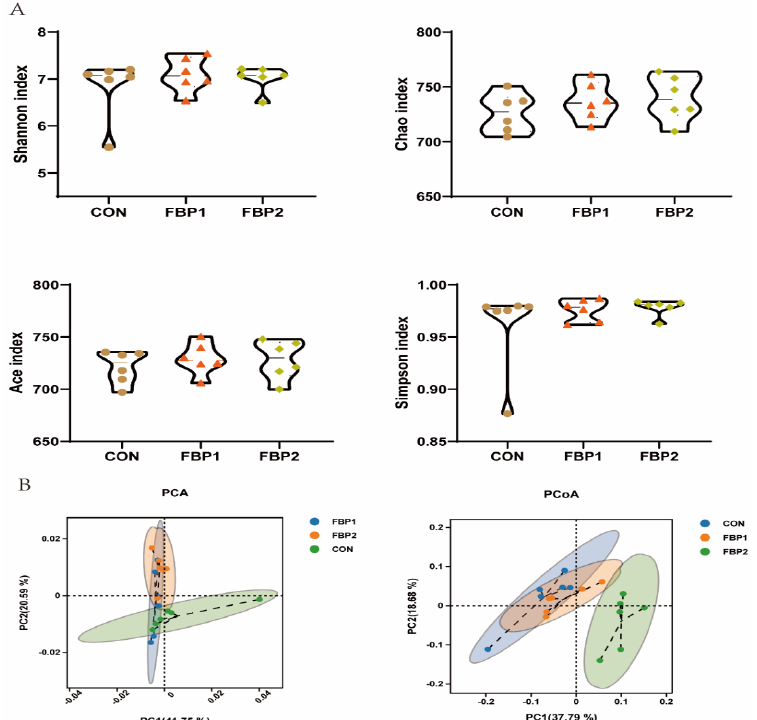
Figure 1. Diversity analyses of microbial communities among dietary groups. ( A ) Alpha diversity analysis. ( B ) Beta diversity with principal component analysis (PCA) and principal coordinates analysis (PCoA) based on unweighted Unifrac distance. CON, control diet. FBP1, the 5% fermented bamboo powder supplementation diet. FBP2, the 10% fermented bamboo powder supplementation diet.